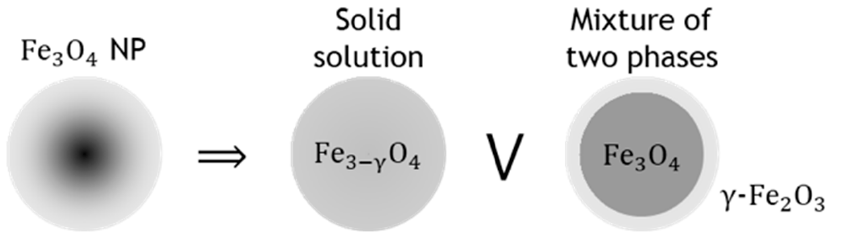
( f ) Figure 9. Mössbauer spectra of the initial ( a ) and annealed at temperatures of 100 °C ( b ), 200 °C ( c ), 400 °C ( d ), 600 °C ( e ), 800 °C ( f ) Fe 3 O 4 @Au nanoparticles (on each spectrum shows the positions of the resonance lines of the subspectra used for model fitting; the lines corresponding to magnetite are shown in blue, and the lines corresponding to hematite are shown in orange). In the general case, a magnetite nanoparticle can be represented as a particle with a